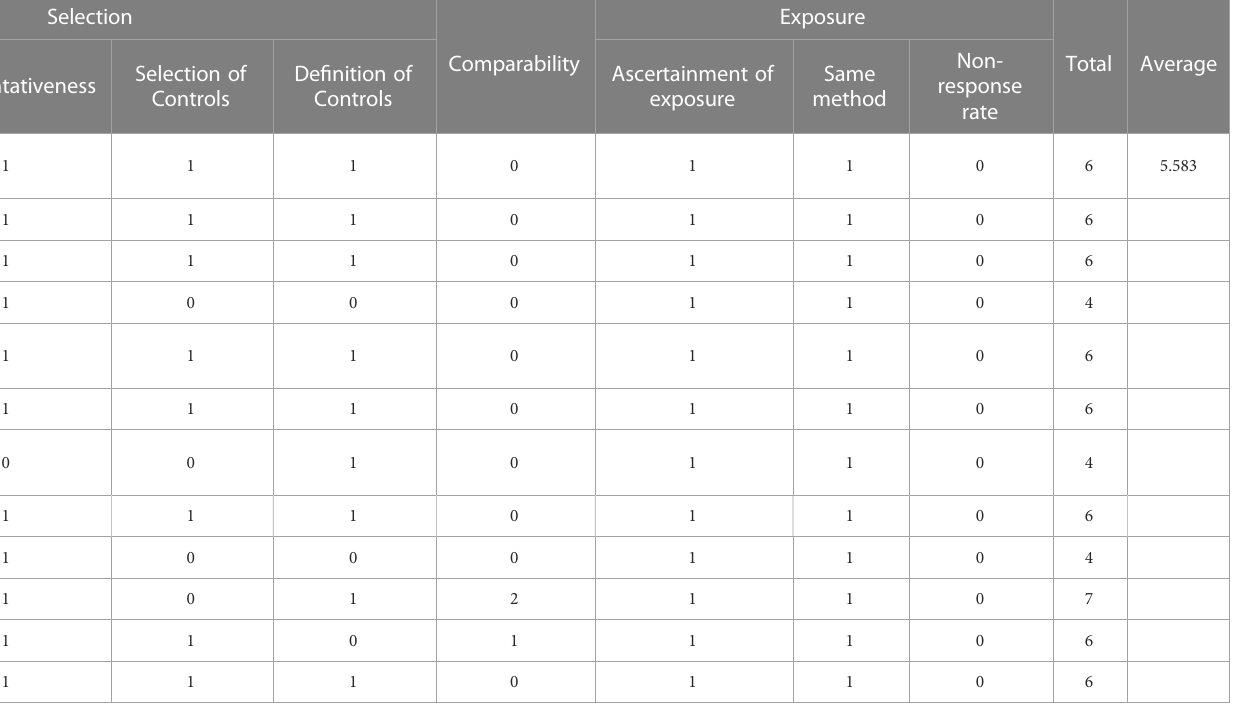
TABLE 2 The Newcastle – Ottawa Scale (NOS) score of included